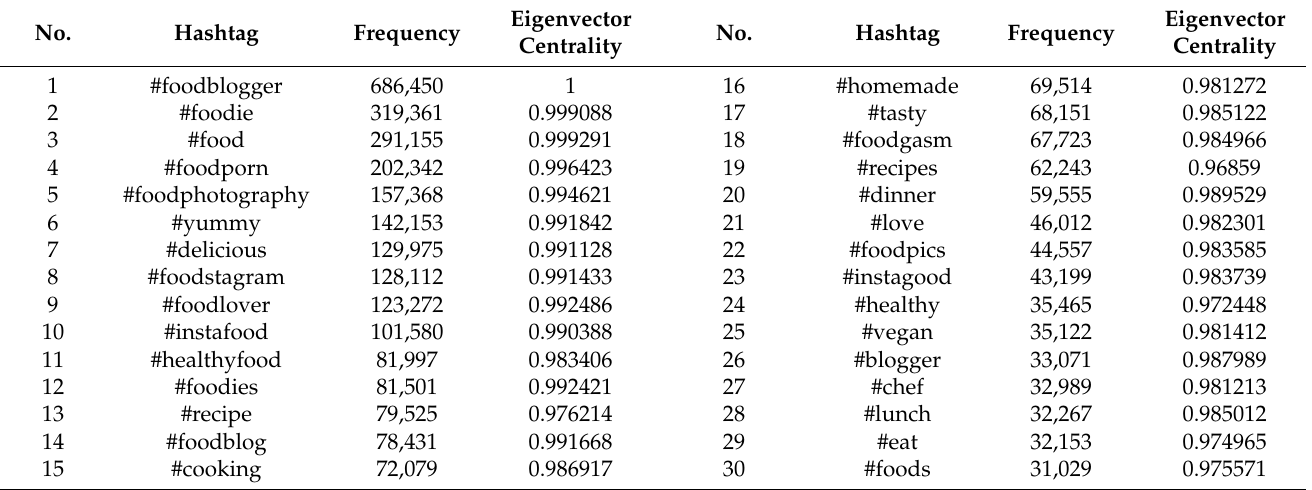
Table 1. Hashtags tweeted in connection with the hashtag #foodblogger on